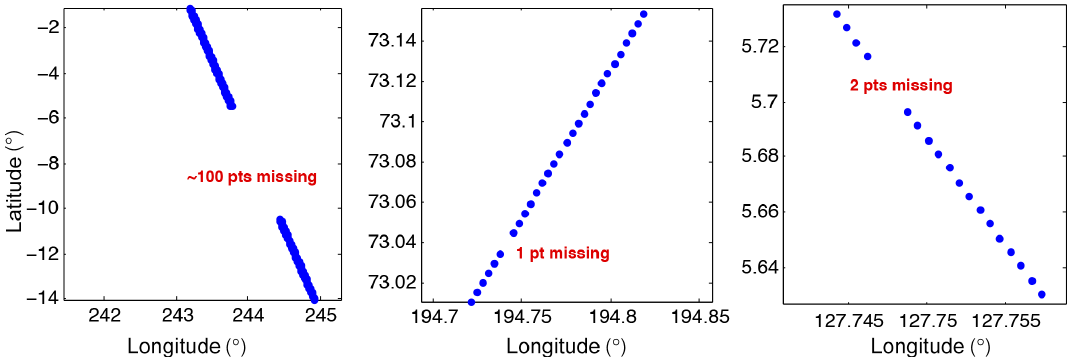
Figure A1. A few examples of irregularly spaced points in the MOLA database.